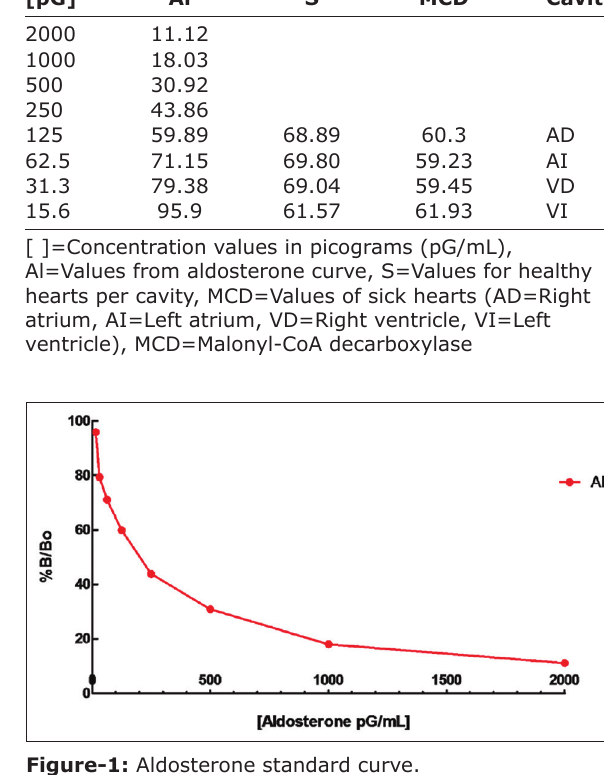
Figure‑1: Aldosterone standard curve.